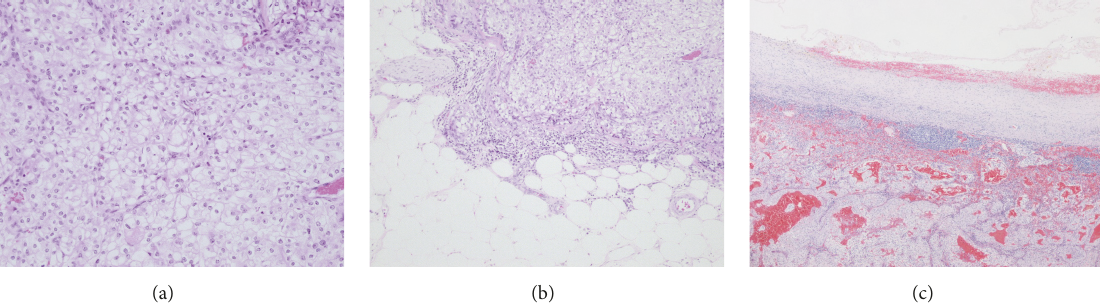
Figure 2: The cancer nests of the epithelial cells with a clear cytoplasm and a distinct cell membrane, separated by many capillary vessels (a) and perinephric fat invasion in the renal tumor (b). The same histological nests are seen in the renal tumor and the cystic lymph node (c).